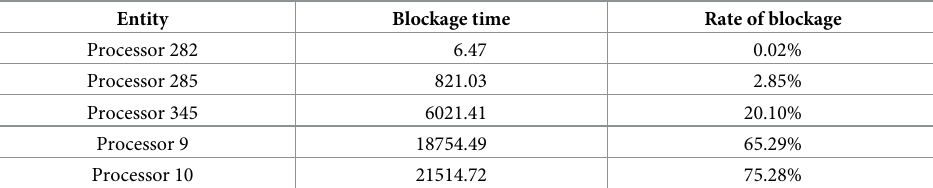
Table 9. Equipment blockage